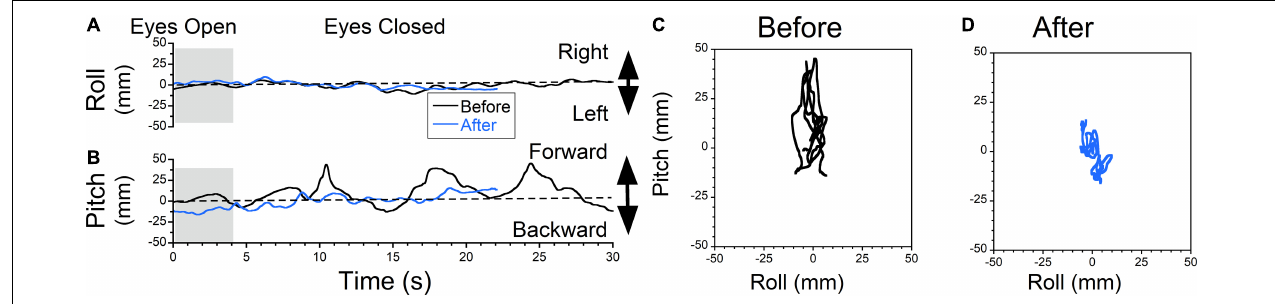
FIGURE 8 | Static posturography of a 71-year-old female with MdDS triggered immediately after a cruise. Details of individual plots are described in Figure 6 . The patient reported a sensation of forward gravitational pulling. Body deviation side-to-side were minimal ( A , black traces). When the patient closed her eyes, the body was gradually falling forward, but when deviation reached certain level, it was pulled back toward upright position ( B , black trace). After exposure to downward OKS at 5 ◦ /s for 2 min, the swaying remained minimal ( C , blue trace) and forward body deviation was reduced (D) . Self-score of overall symptoms prior to treatment was 7/10, and after treatment was 4.5/10. TABLE 2 | Frequency of individual symptoms at long-term follow-up in successfully and unsuccessfully treated groups.